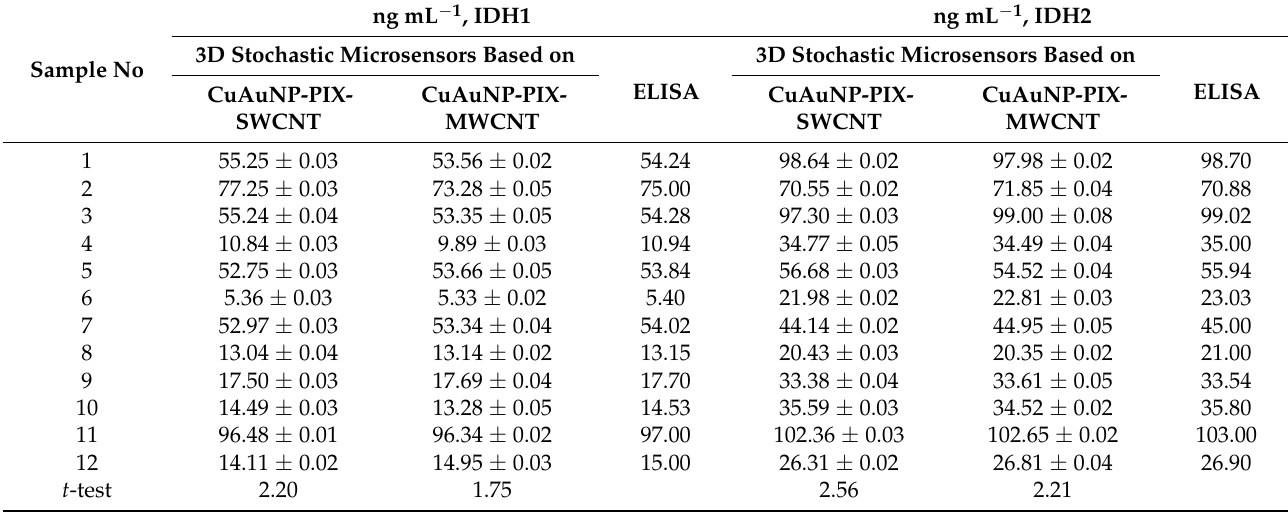
Table 5. Determination of IDH1 and IDH2 in whole blood samples using the stochastic microsensor and